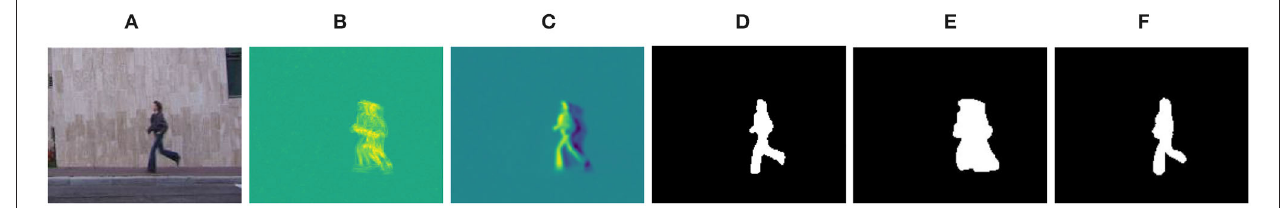
FIGURE 7 | Example of pooling and segmentation maps obtained by our method: (A) Reference frame, (B) ST-MAX, (C) T-AVG, (D) ground truth, (E) adaptive segmentation over ST-MAX (GCKs-A), (F) refined final map using information about “present” and “past” (GCKs-R).